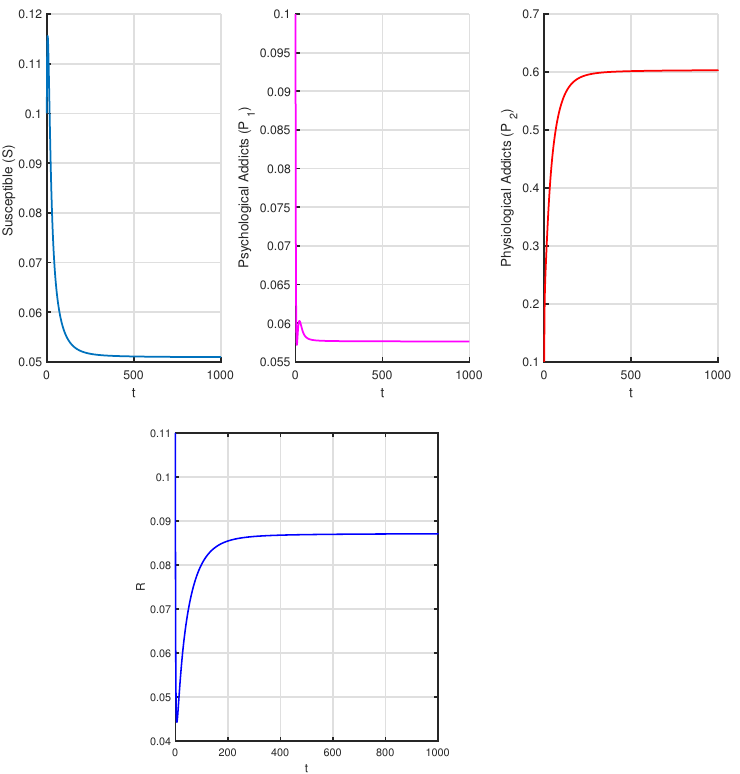
Figure 5. Time series of system (3) corresponds to Table 5 when E 1 = ( 0.051,0.0576,0.6081,0.0871 ) and R 0 =